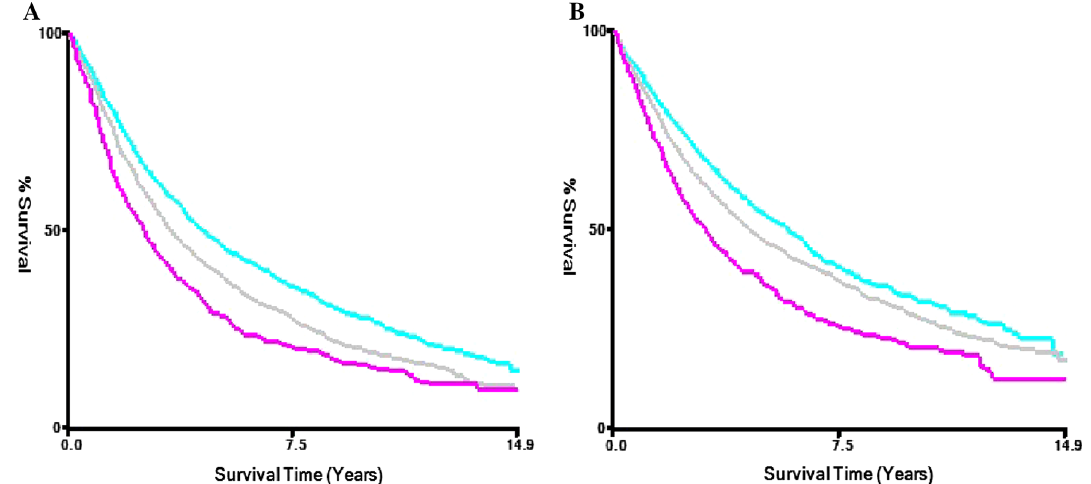
Fig. 8 Kaplan–Meier survival curves is drawn for the number of lymph nodes subpopulation stratified by the LNR. A The number < 10. B The number >